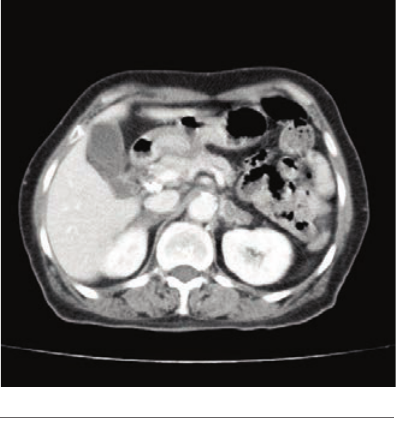
Figure 3. 18-FDG PET CT (coronal and axial view; A and B respectively) shows high FDG uptake in the neck, axilla, abdominal, and inguinal lymph nodes and both adrenal